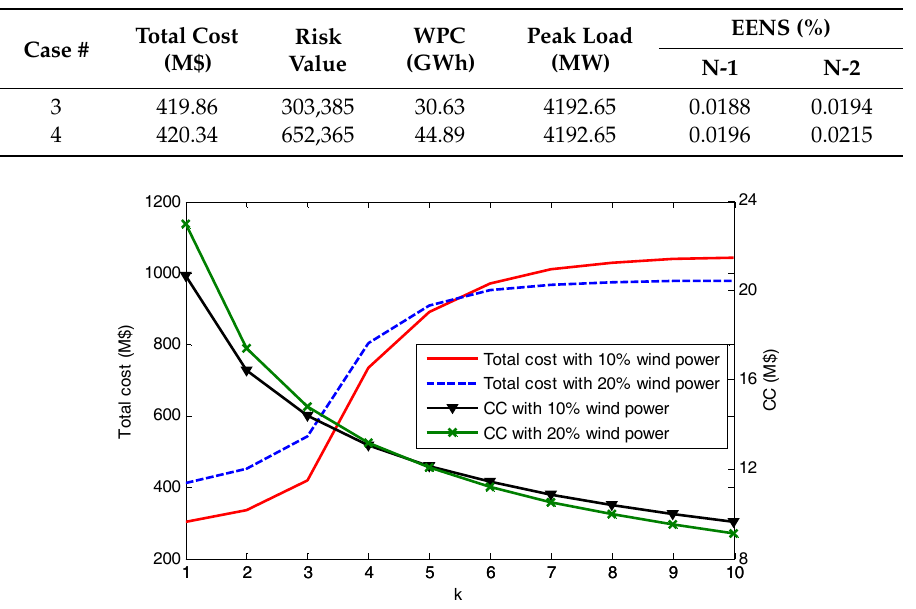
Figure 9. Variations in total cost and corrective control cost (CC) corresponding to different k for case 3.